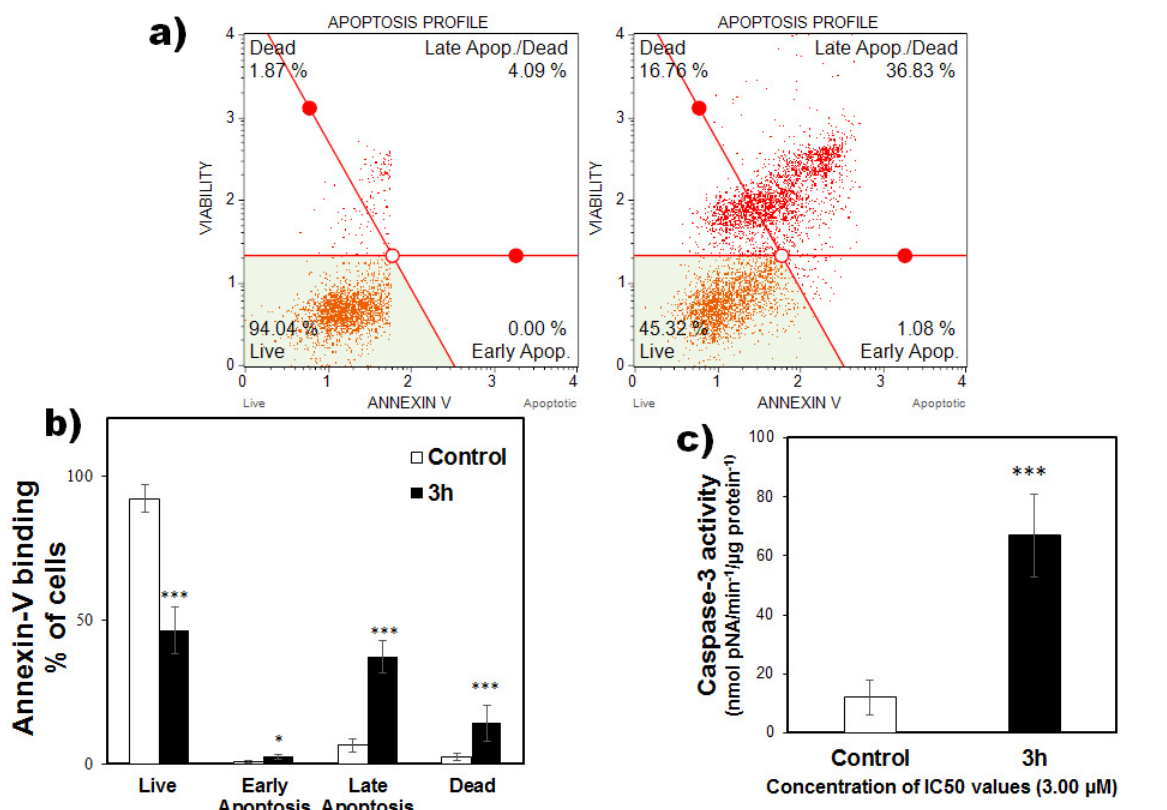
Figure 4 . Apoptosis profile for MCF-7 cells treated with compound 3h (3.00 µM) a) Annexin-V binding b) The percentage of live, early and late apoptosis/dead cells by MUSE cell analyzer c) Caspase‐3 activity (* p < 0.05, *** p < 0.001 vs